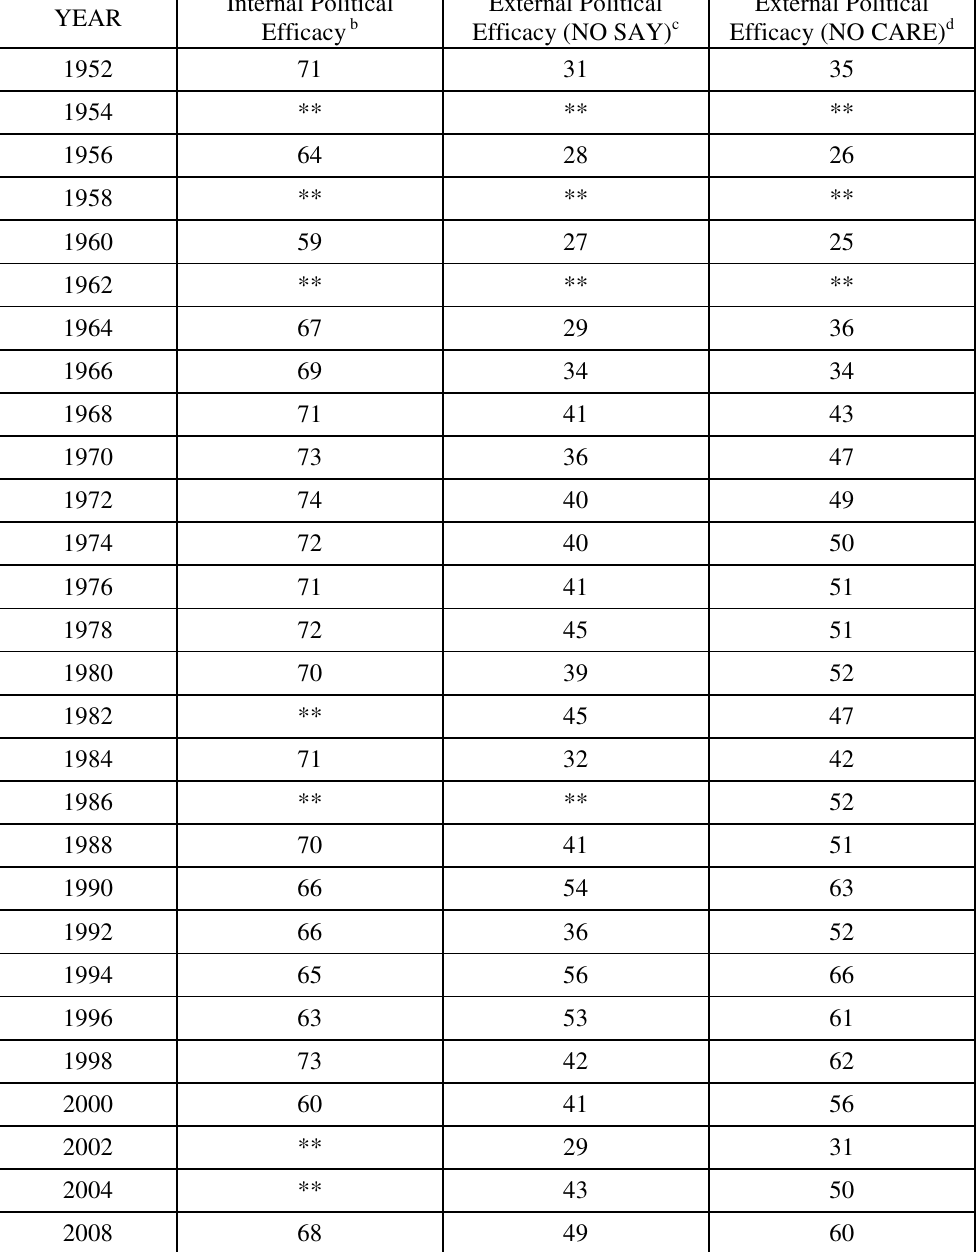
Table 1: Internal and External Political Efficacy, 1964-2008